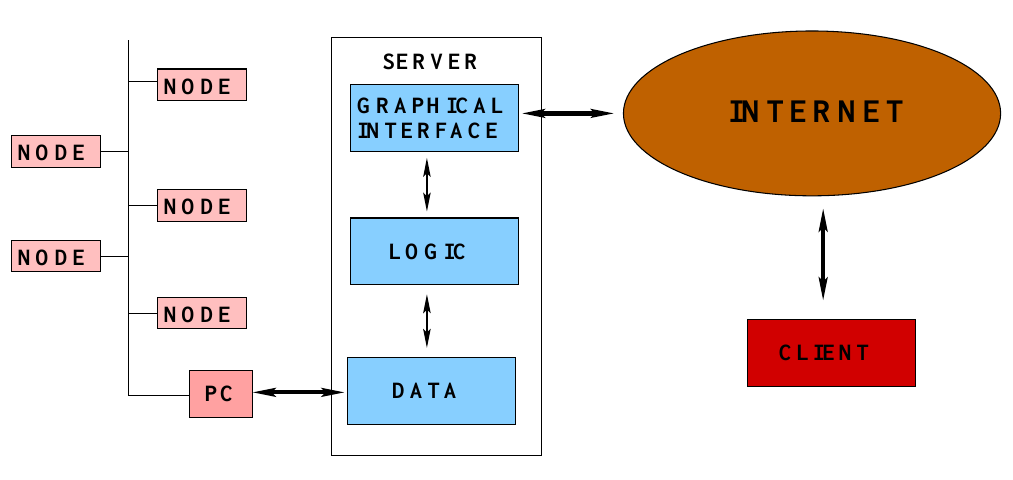
Figure 7. The software